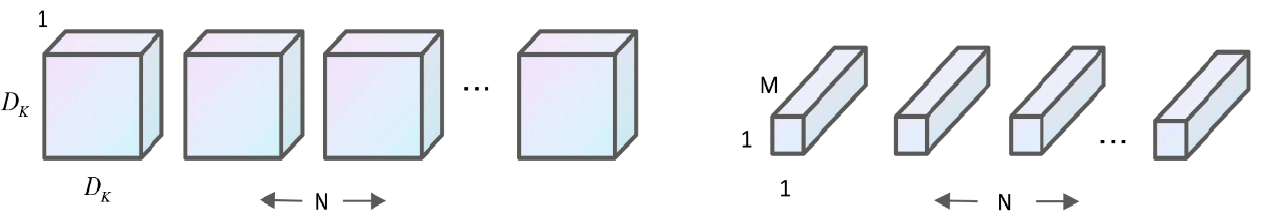
Figure 5. Depth separable convolution.